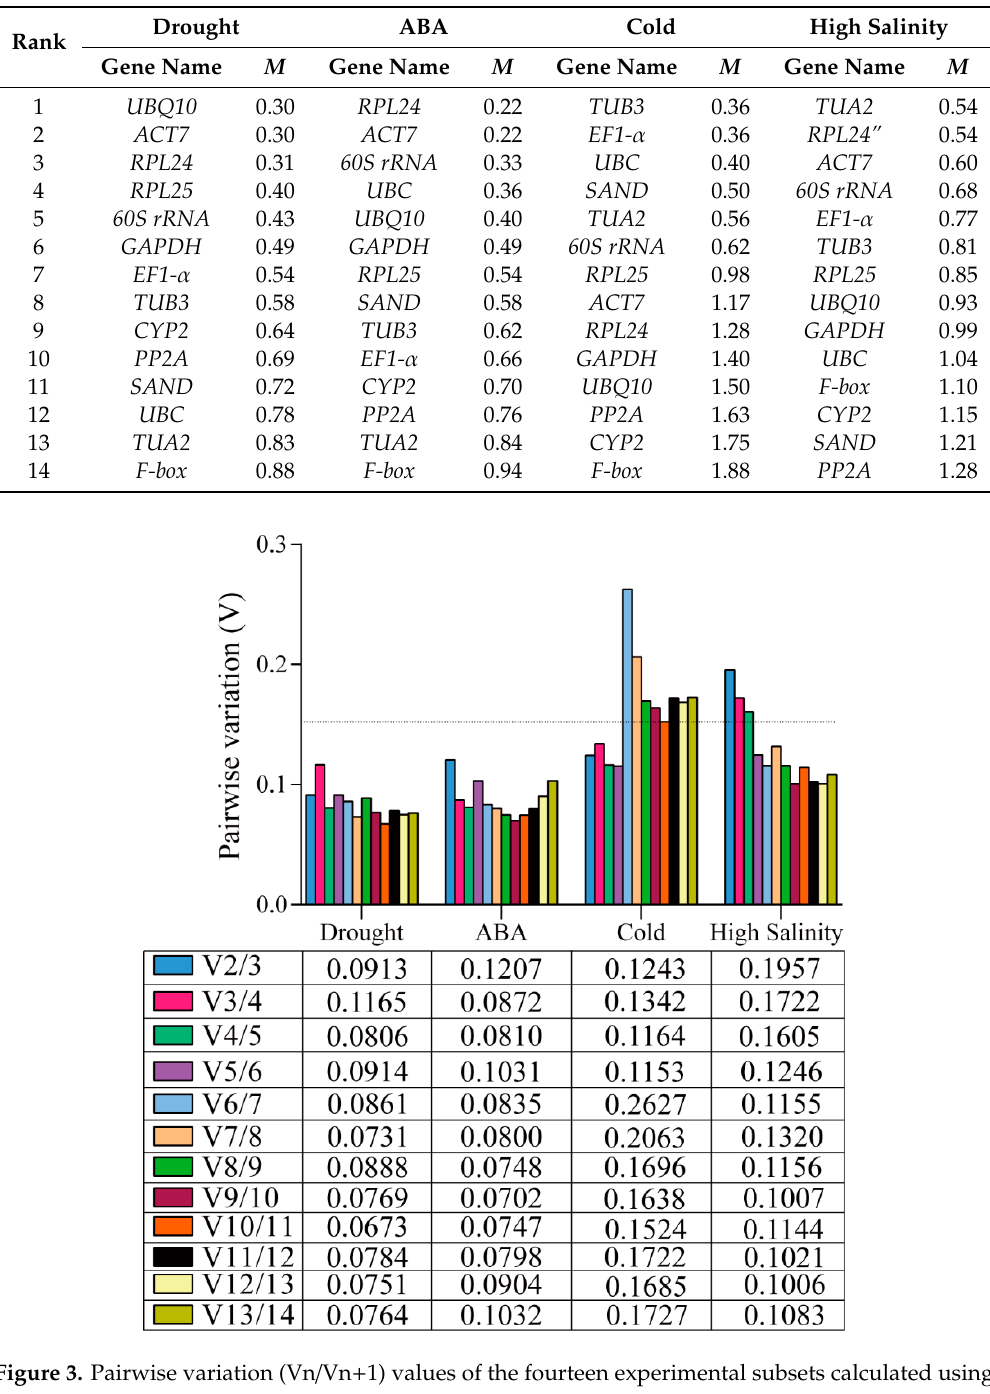
Figure 3. Pairwise variation (Vn/Vn+1) values of the fourteen experimental subsets calculated using geNorm. The cut-off value to determine the optimal number of RGs for qRT-PCR normalization is 0.15.